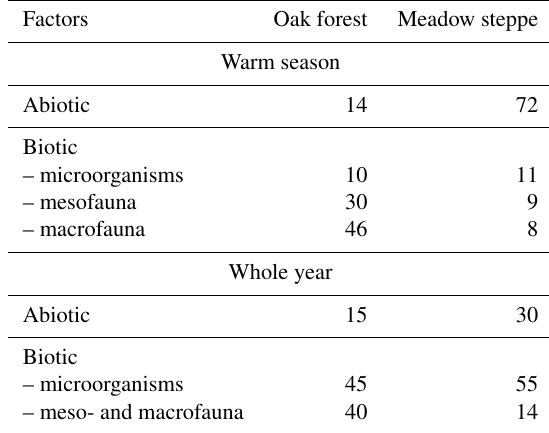
Table 1. Rate of decomposition of dead plant parts (%) during the warm season in two ecosystems of the forest-steppe zone of Russia (Bazilevich et al., 1993). Factors Oak